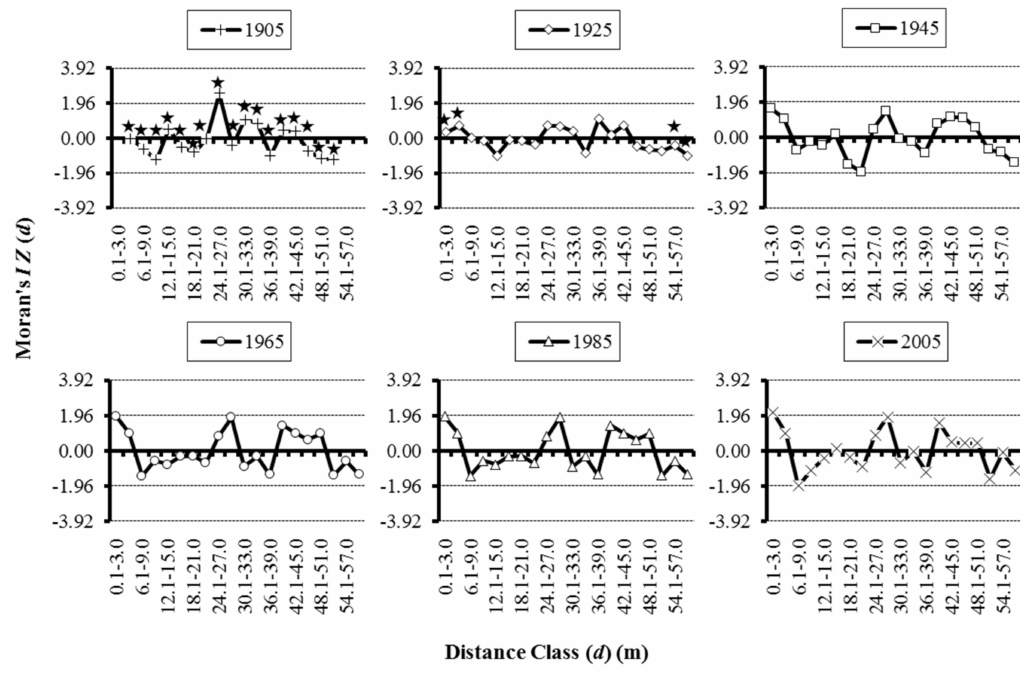
Figure 5. Contemporary and historical spatial autocorrelation correlograms for Mexican piñon ( Pinus cembroides var. cembroides Zucc.) of study site 2. Dotted lines in the middle of each graph indicate the 0.05 significance level and stars ( (cid:70) ) indicate fewer than 20 neighbors for the specified distance